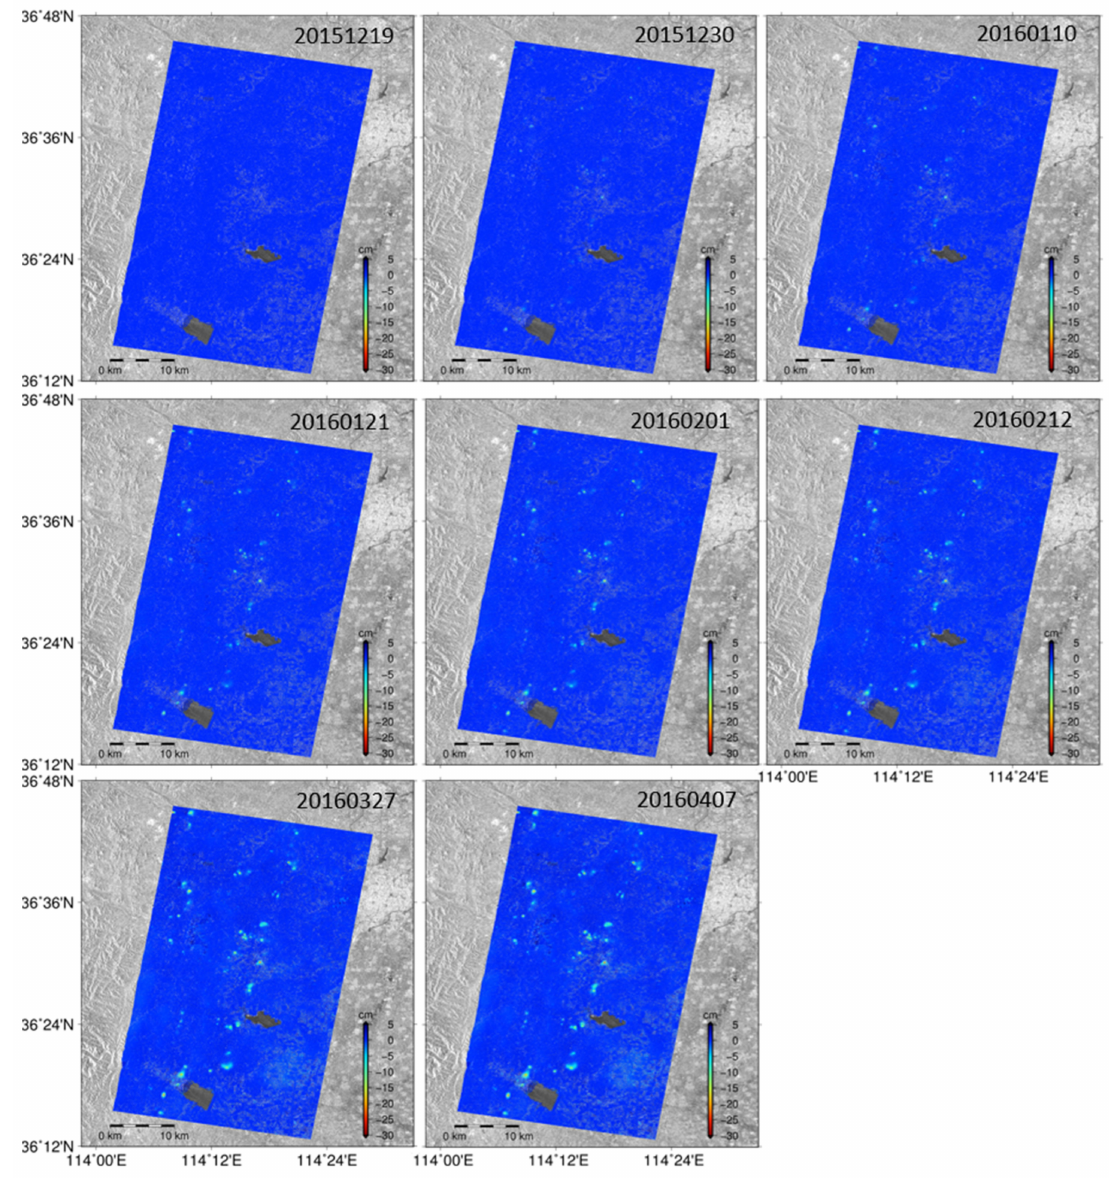
Figure 7. The deformation time series between September 2015 and April 2016, estimated with TerraSAR–Xdata.